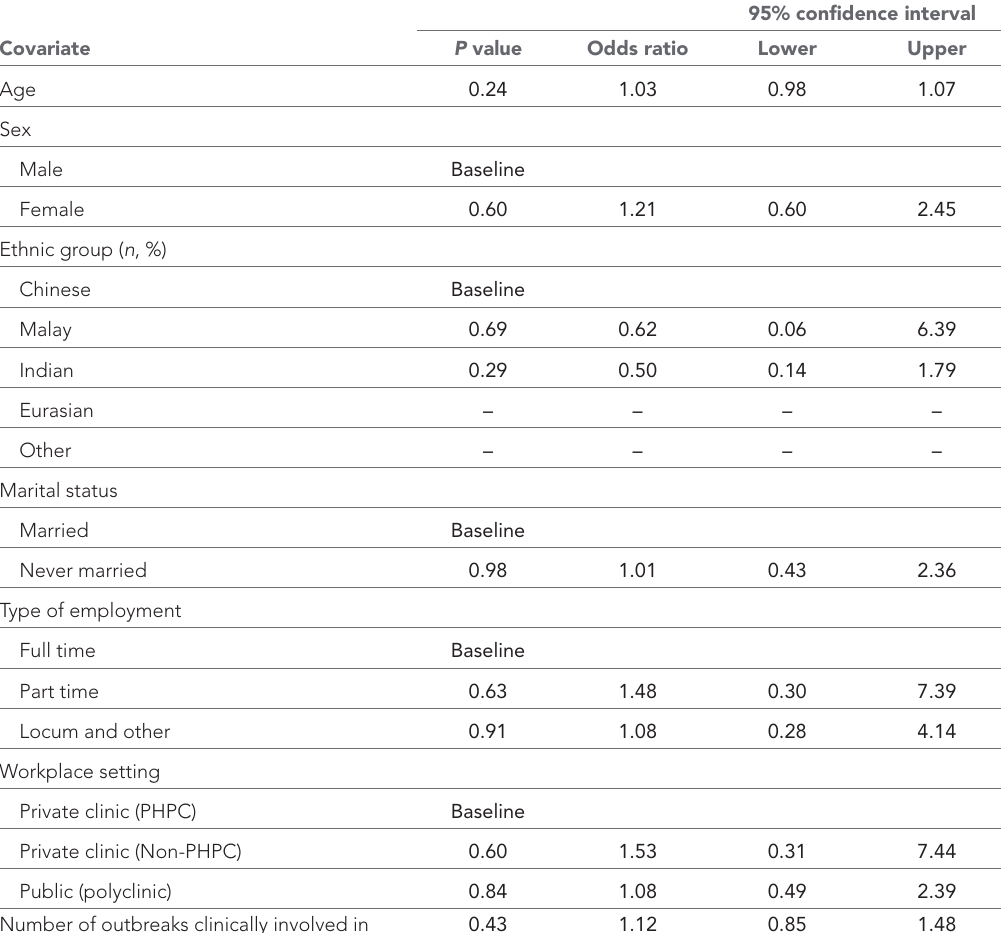
Table 3 Sociodemographic and work environment correlates of burnout